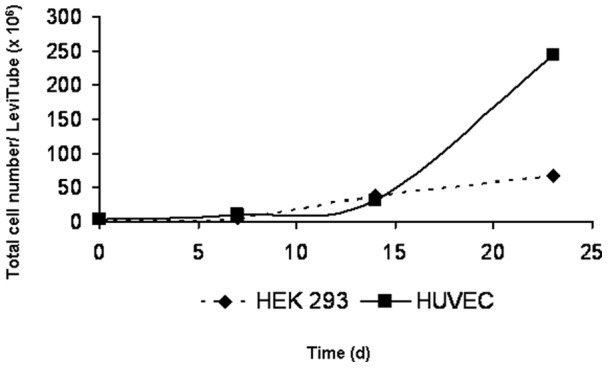
Growth curve of EAhy 926 cultured on basal membrane coated GEM™.Two pre-installed protocols for cell culturing epithelial (HEK 293) and endothelial (HUVEC) cells were compared. (d), days.